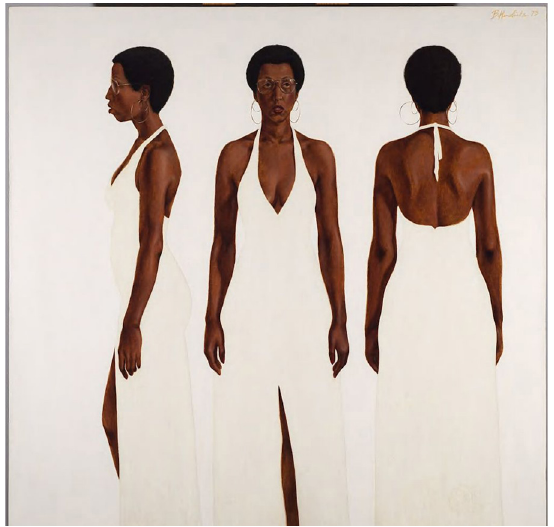
Figure 4. Hendricks, Barkley L. October’s gone... Goodnight , (1973). Oil and acrylic on linen canvas, 72 x 72 inches ©Estate of Barkley L. Hendricks. Courtesy of Jack Shainman Gallery, New